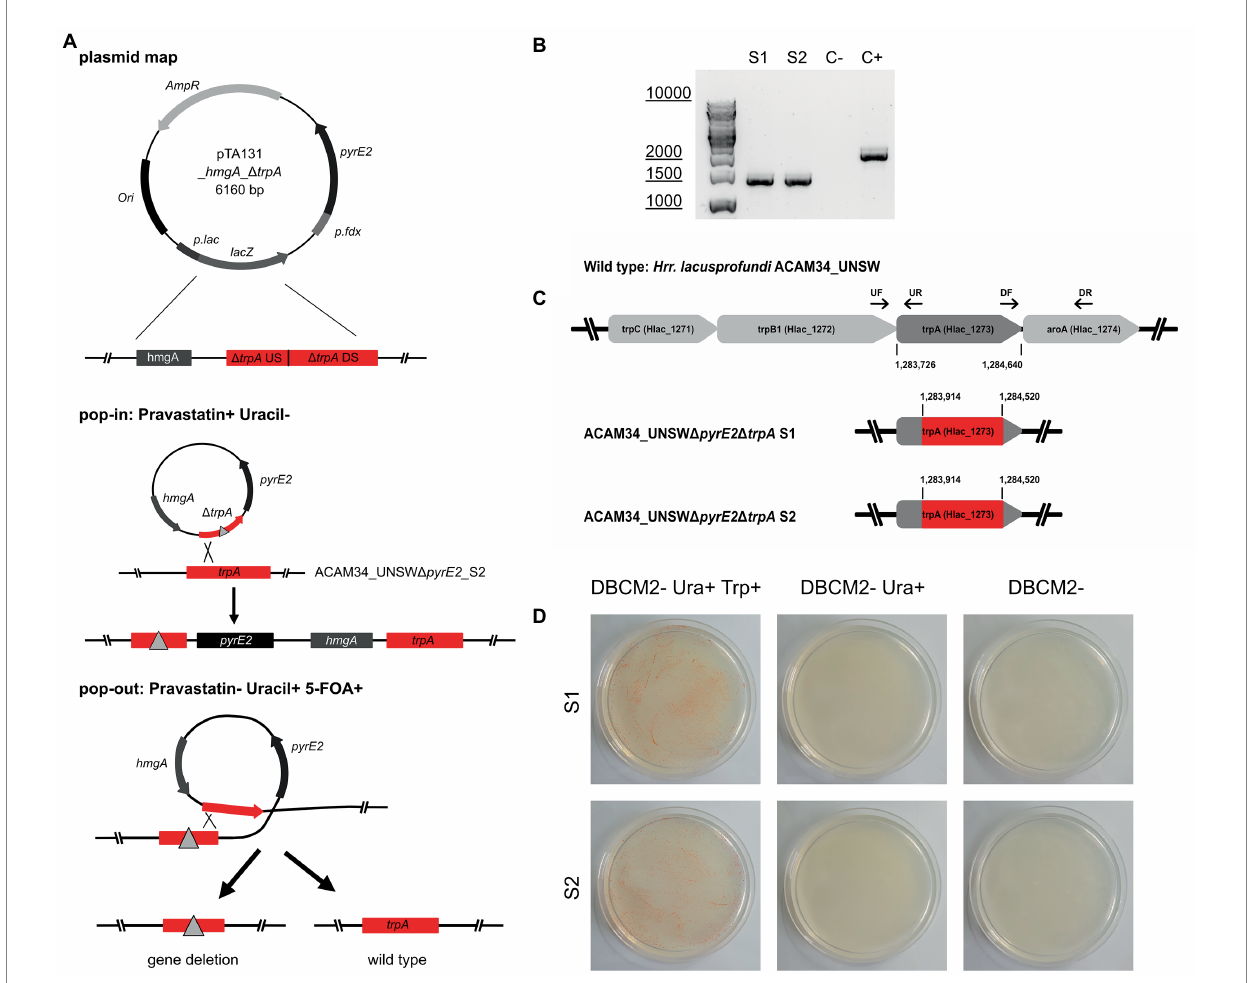
FIGURE 3 Successful trpA knockout in Hrr. lacusprofundi ACAM34_UNSW Δ pyrE2 . (A) Recombination strategy used to generate ACAM34_UNSW Δ pyrE2 Δ trpA via double selection. A vector based on pTA131 (Allers et al., 2004) (with pyrE2 for uracil synthesis), was used to insert a pravastatin resistance gene ( hmgA ), as well as a non-functional copy of the trpA gene created by the fusion of upstream (US) and downstream (DS) fragments of the gene. Both the non- functional gene (represented by a triangle) and the functional wild-type trpA gene are marked in red. Crossover at the trpA genes leads to the integration of the plasmid into the genome (pop-in) using uracil depletion and the addition of pravastatin as selection pressure. Excision of the plasmid (pop-out) is enforced by the addition of 5-FOA and uracil, through which either the non-functional construct (left) or the wild-type gene (right) remains in the genome. (B) PCR on the trpA locus of the two knockout strains S1 and S2, with a wild-type ACAM34_UNSW control (C+) and a negative control (C − ). (C) Operon encoding genes for tryptophan synthesis in the wild-type strain ACAM34_UNSW including the position (bp) of trpA and the primer binding sites for upstream (UF, UR) and downstream (DF, DR) flanking regions amplified for the deletion construct. Deletion in ACAM34_ UNSW Δ pyrE2 Δ trpA S1 and in ACAM34_UNSW Δ pyrE2 Δ trpA S2 highlighted in red. (D) Growth of ACAM34_UNSW Δ pyrE2 Δ trpA S1 (top) and S2 (bottom) on DBCM2 supplemented with uracil and tryptophan (left), growth defect on DBCM2 with uracil but without tryptophan (middle), growth defect on DBCM2